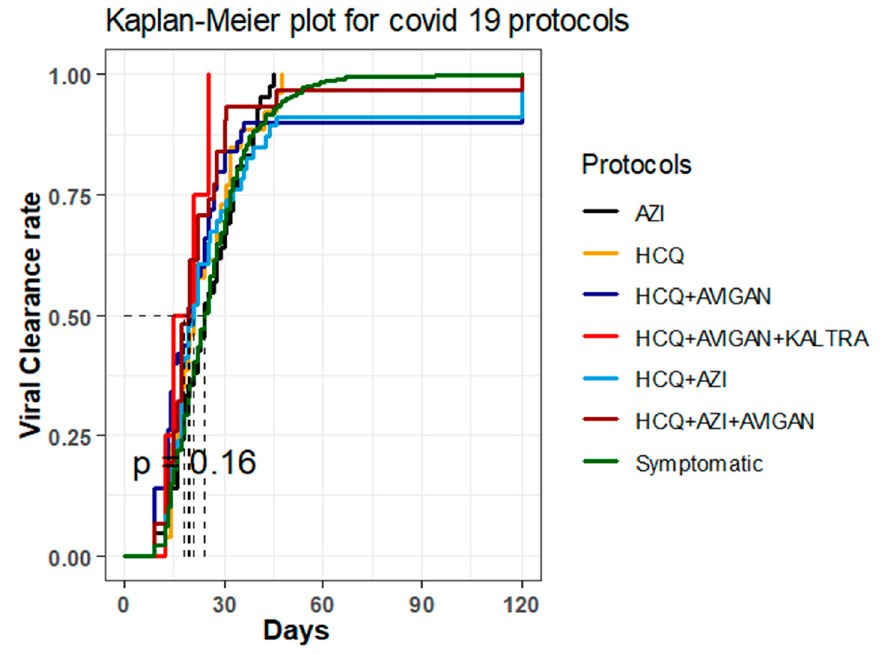
Figure 1. Kaplan–Meier plot for COVID-19 protocols.